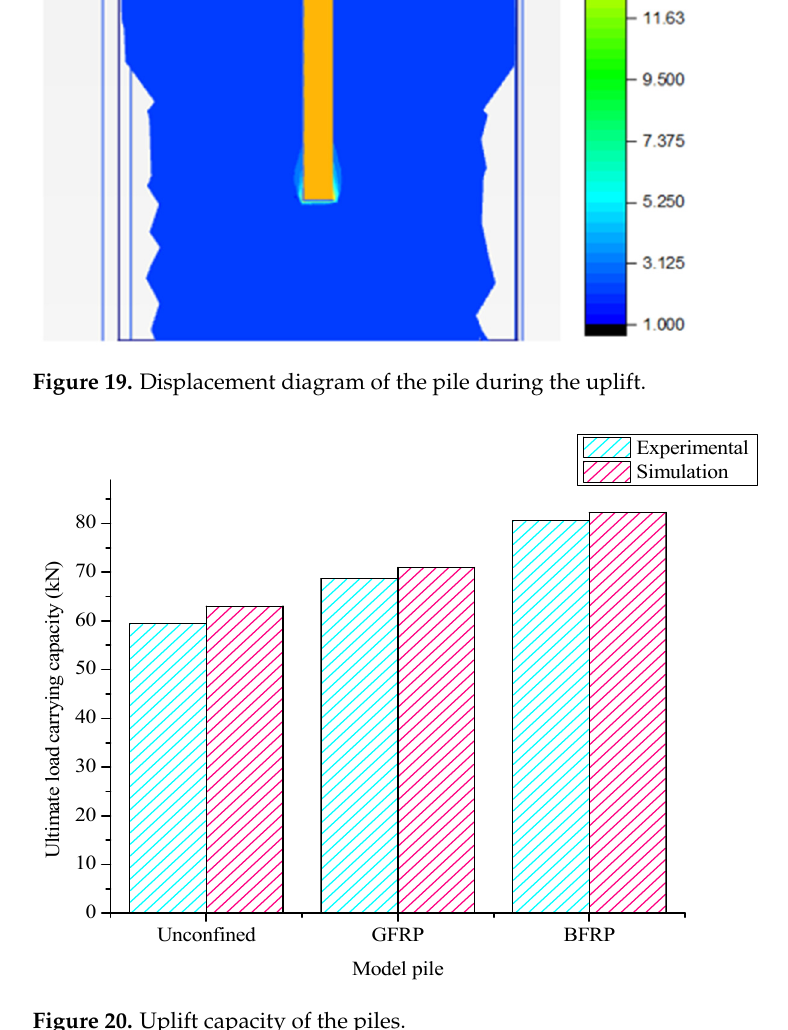
Figure 20. Uplift capacity of the piles.